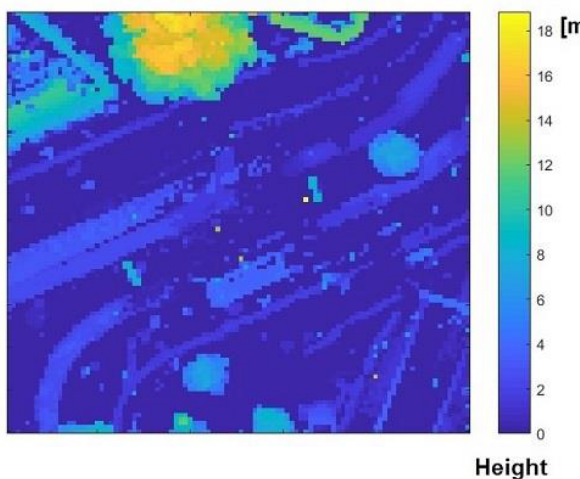
Figure 6. Maximum height above ground level in 50x50cm tiles The above features are assigned to individual points resulting in a point-wise classification, i.e. the individual point is considered as the object. When introducing tiles as objects, other features may be derived, including number of points present in the column (N) and difference between maximum and minimum height values ( △ h). Figure 6 shows △ h for tiles of 50x50cm of the point cloud shown in Figure 5.